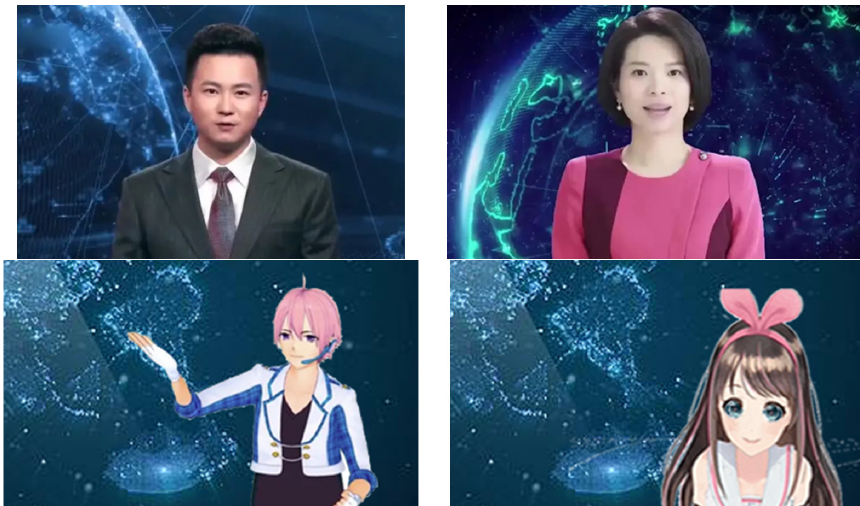
Figure 1. Experimental materials.